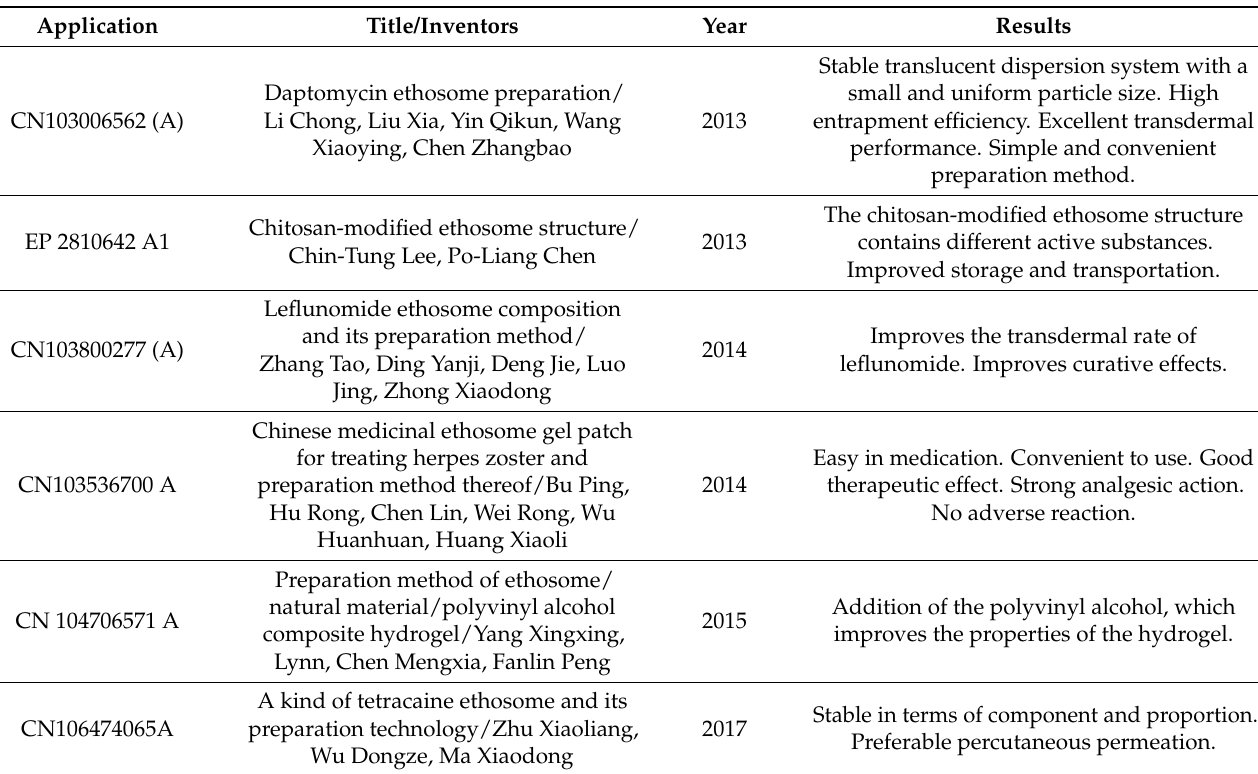
Table 3. Presentation of some of the patents for the application of ethosomes in skin